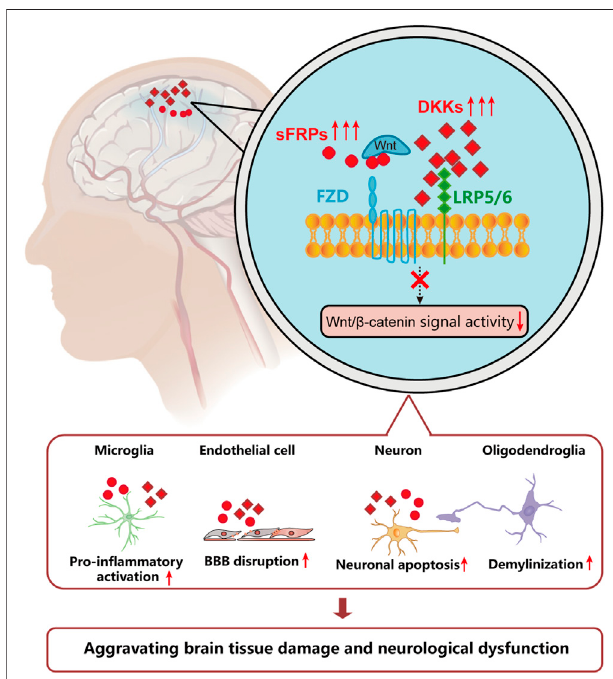
FIGURE 3 | The potential implications of Wnt/ β -catenin among cells from ischemic brain. After an ischemia incident, the microenvironment in ischemicbrainleadstodecreasedactivityofWnt/ β -cateninsignalingpathway. TheregulatorymechanismsofwhichincludeincreasedlevelofDkksand sFRPs, which leads to increased BBB disruption, neuronal apoptosis, demyelination, and overactivation of microglia.